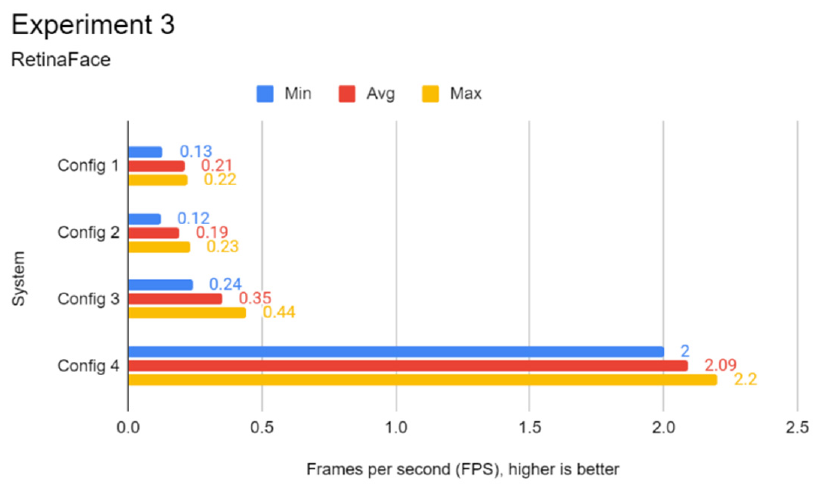
Figure A10. Bar chart FPS results for all systems running RetinaFace for face detection in Experiment 3.